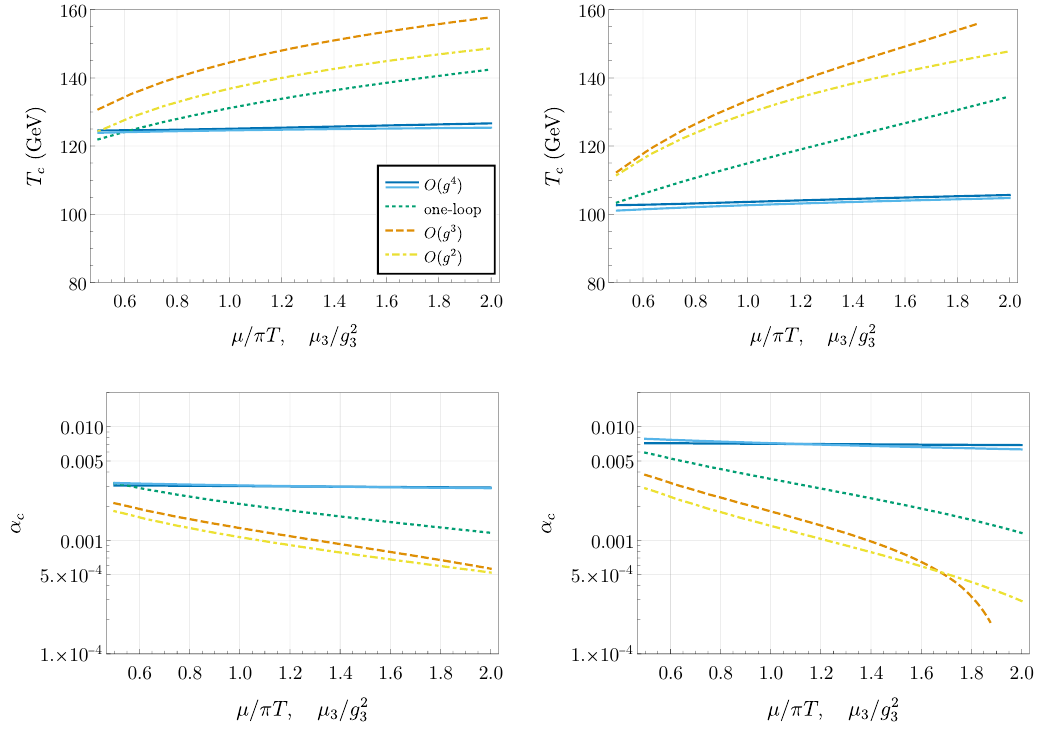
Figure 4. T c and α c as functions of the renormalisation scales, for BM1 on the left and BM2 on the right. For the O ( g 4 ) approximation, dark blue is µ -dependence and light blue is µ 3 -dependence. Only the full O ( g 4 ) accurate approximation shows signs of a controlled RG-scale dependence, in accord with the generic arguments of previous